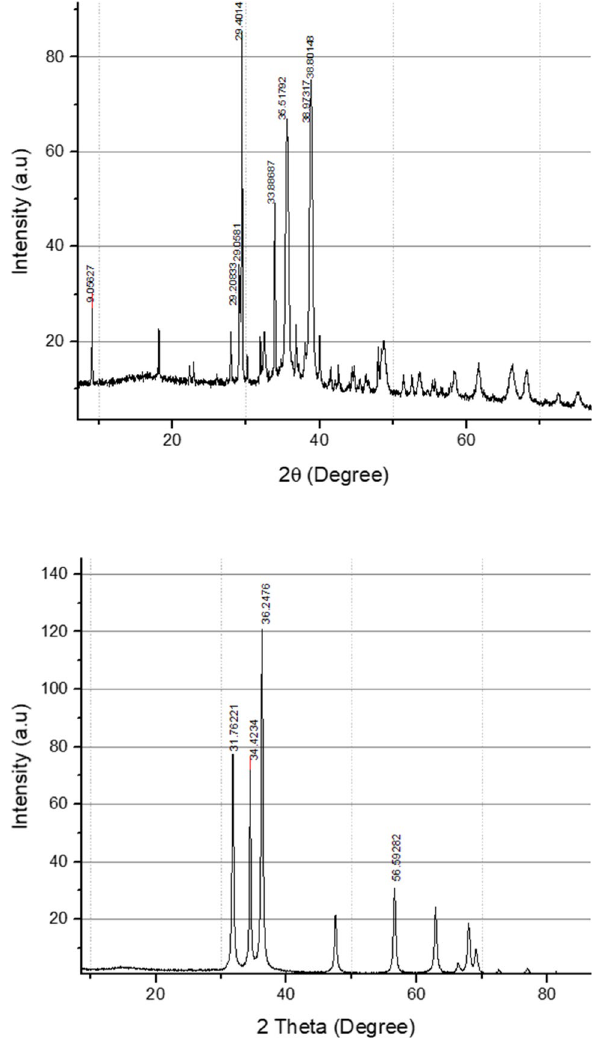
Fig. 3 XRD Pattern of synthe- size CuO Nanoparticles